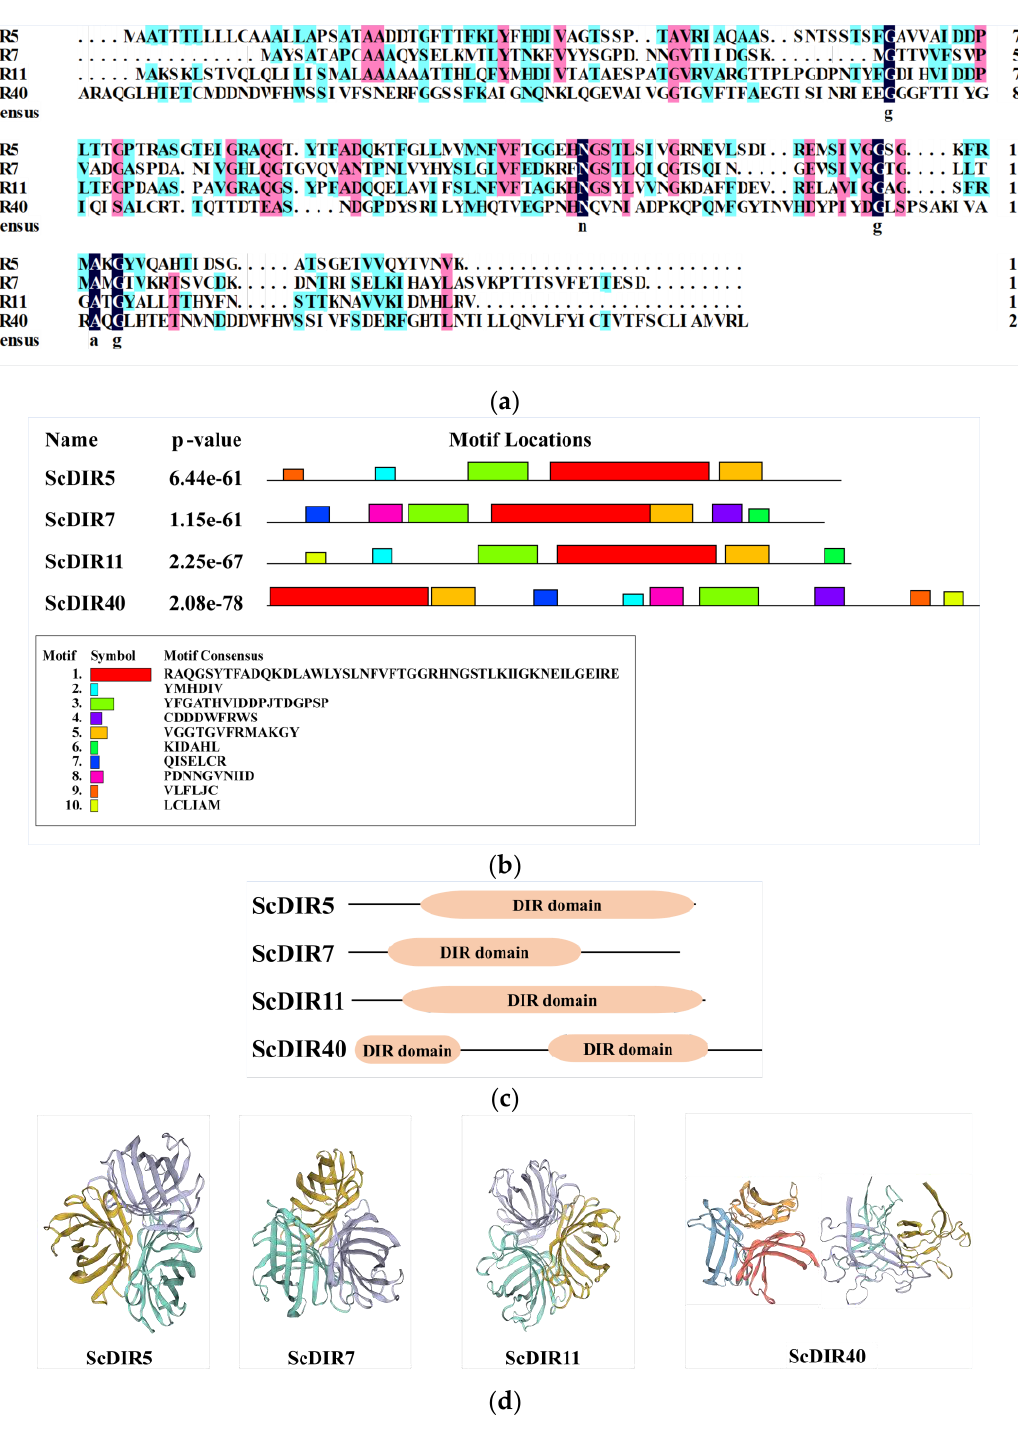
Figure 3. Protein sequence analysis, conserved domains, and tertiary structures of ScDIR5, ScDIR7, ScDIR11, and ScDIR40. ( a ) protein sequence alignment. ( b ) conserved protein motifs predicted with MEME Suite software. ( c ) DIR domain. ( d ) tertiary structures of the ScDIRs predicted using SWISS − MODEL online software, using PsPTS1 as a template. Two structures were predicted in ScDIR40, one of them (right − most) may not be